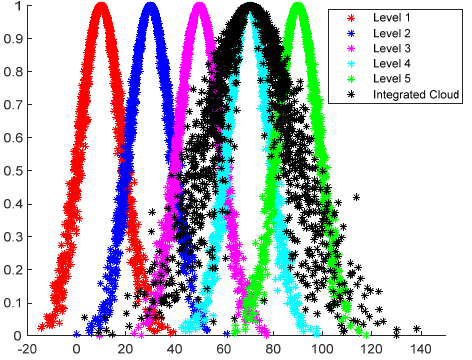
Figure 8. Material and equipment risk integrated cloud vs. standard cloud.